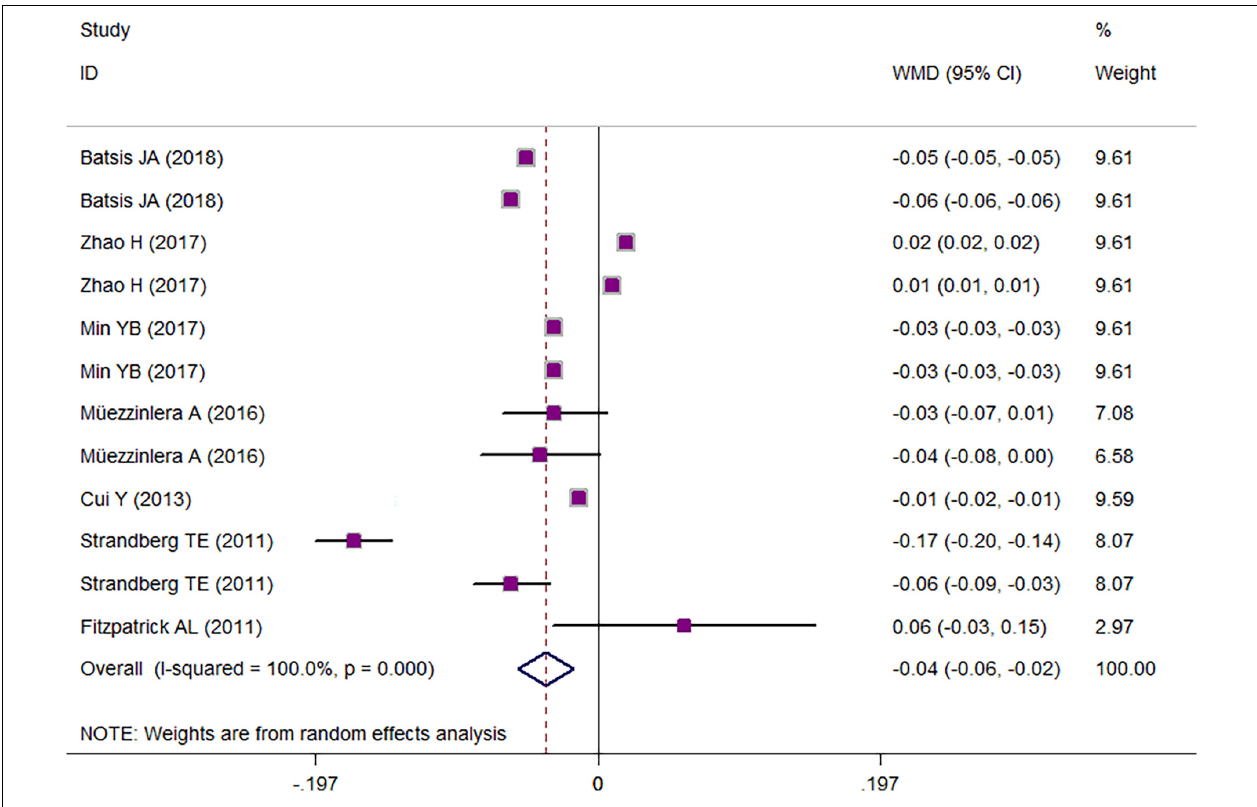
FIGURE 3 | Weighted mean difference (WMD) with 95% confidence interval (CI) of the comparison of leukocyte telomere length in obese vs. non-obese.